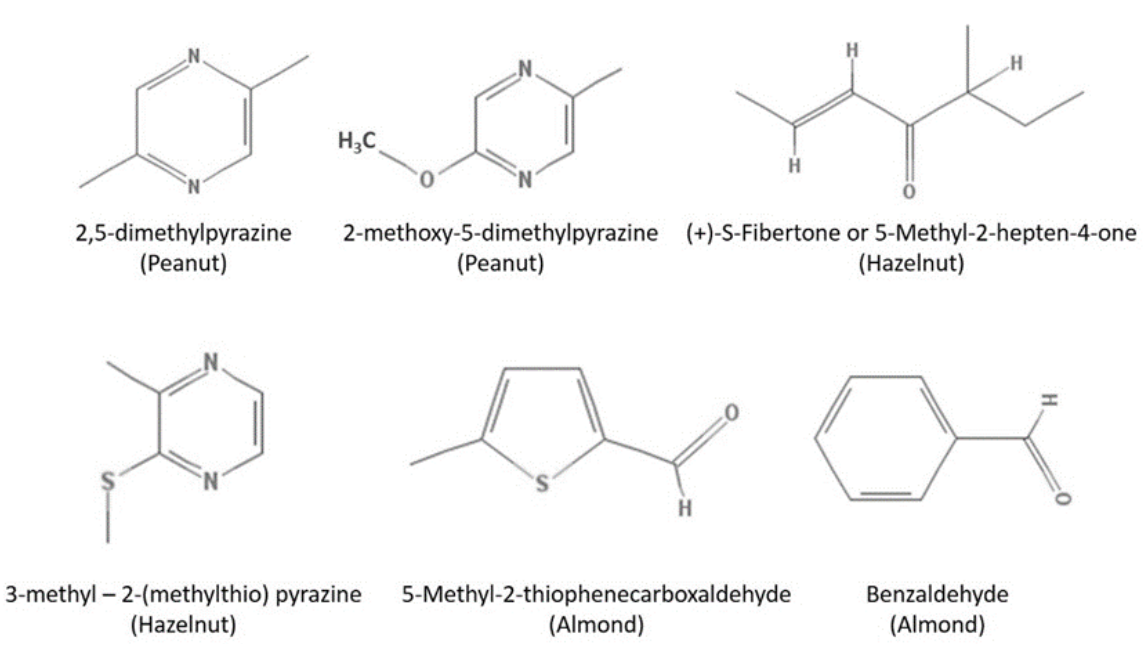
Figure 1. Some representative flavor compounds in almonds, peanuts, and hazelnuts.